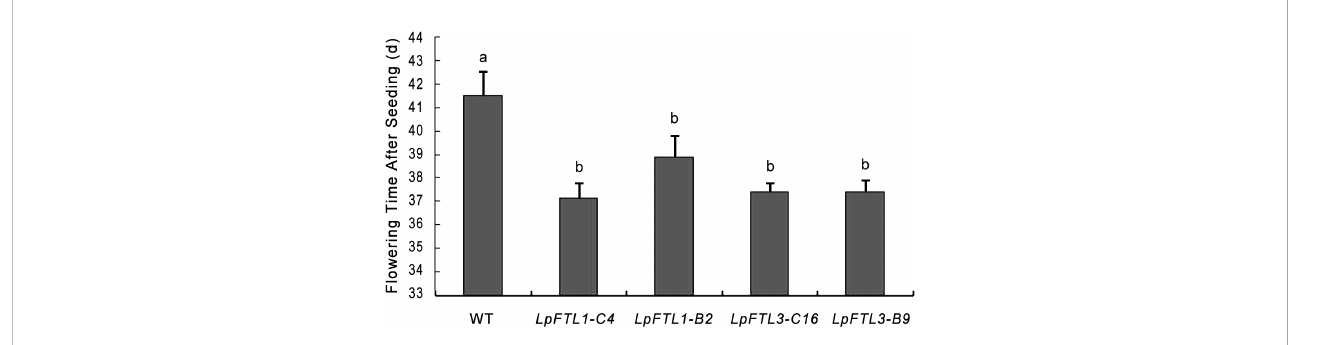
FIGURE 5 Flowering time statistics of FTL1-C4, FTL1-B2, FTL3-C16, FTL3-B9. Different superscripts indicate signi fi cant differences between means at P<0.01 according to Tukey ’ s test. Values are mean ± SD (from three biological replications).